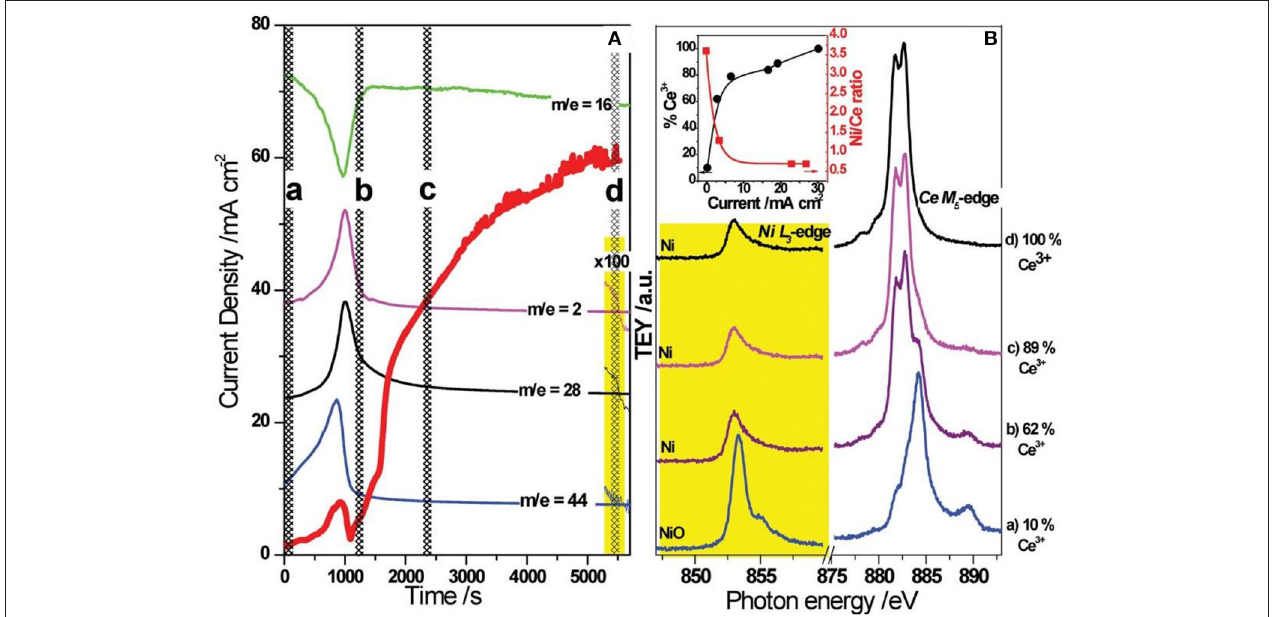
FIGURE 4 | Combined mass spectrometry, chronoamberometry, and NEXAFS results under anodic polarization: (A) The current density flowing between the working and counter electrode of the solid oxide electrode assembly as a function of time (red line). The corresponding on line mass spectrometry signals of CH 4 (m/e = 16), H 2 (m/e = 2), CO (m/e = 28), and CO2 (m/e = 44) are also presented in the graph (green, magenta, black, and blue lines, respectively). The yellow highlighted area shows a magnification (100 times greater) of the mass spectrometry signals when the applied bias voltage sets off. Cell operating conditions: pre-oxidized sample under anodic polarization + 1V, 0.1 mbar CH 4 at 700 ◦ C. (B) Selected sequence of Ni L3- and Ce M5-edge NEXAFS spectra during anodic polarization at different times of the experiment (the time of each spectrum recording is indicated in the figure on the left, by a, b, c, and d). The% presence of the Ce 3 + component in the overall Ce M 5 -edge obtained after deconvolution is given to the right. Inset, The% Ce 3 + (measured by NEXAFS) and the Ni/Ce ratio (measured by APPES) as a function of the measured current density flowing between the anode and the cathode. Lines are guides to the eye. Reprinted with permission from Papaefthimiou et al.